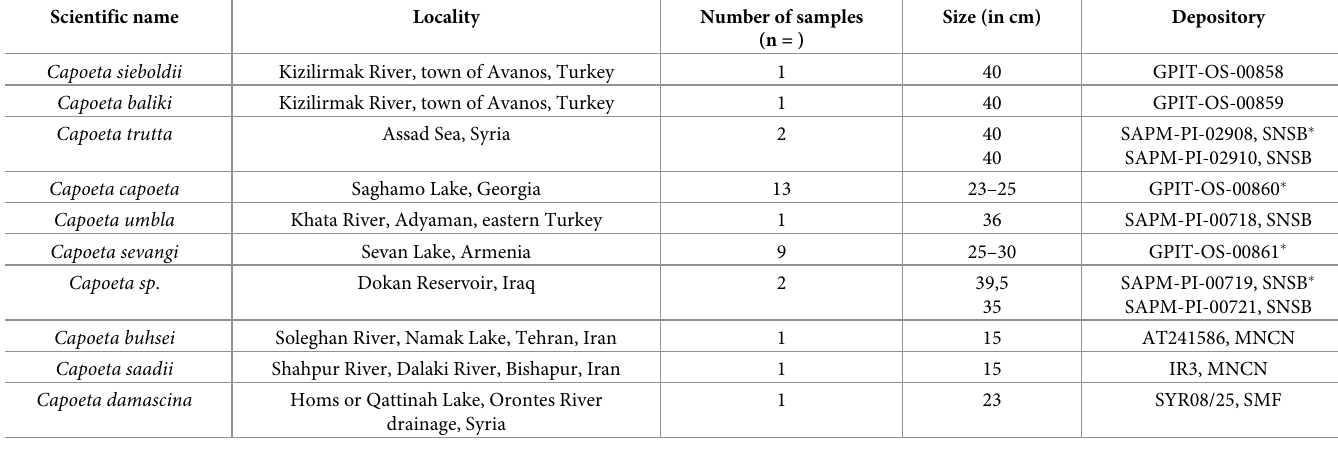
Table 2. Comparative material of extant Capoeta